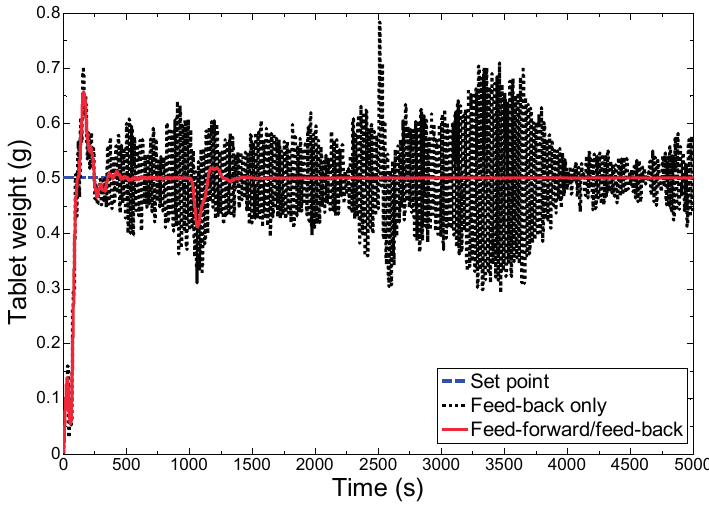
Figure 7. Comparison of the performance of the combined feed-forward/feed-back control scheme with feed-back only control scheme for tablet weight